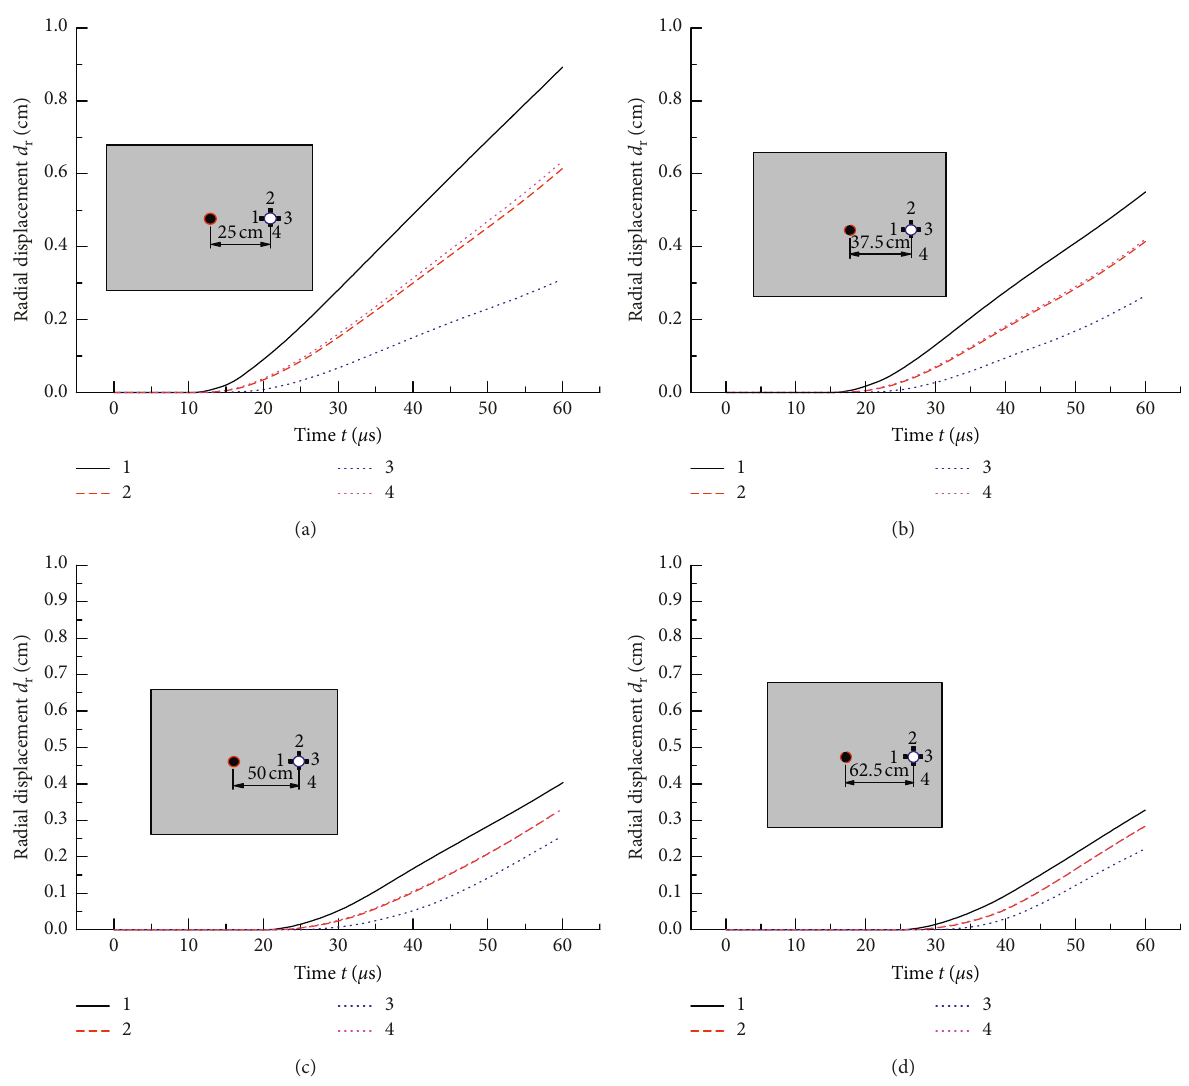
Figure 9: Radial displacement of adjacent empty holes wall with different hole spacing. (a) a /2 r (d) a /2 r 1 � 12.5.